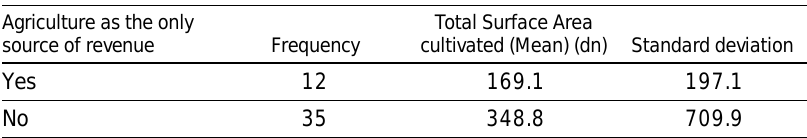
Fisher’s exact test p value is 0.258 Table 6. Agriculture as the Only Source of Revenue With Respect to Total Surface of Area Cultivated Agriculture as the only source of